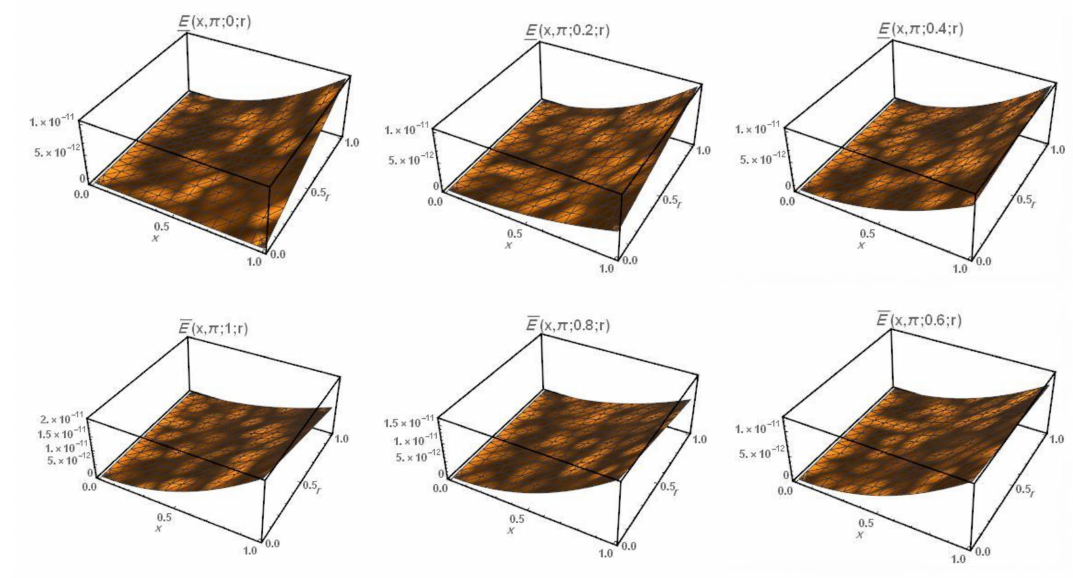
Figure 8. Accuracy of the tenth-order double parametric fuzzy HPM solution at t = π , b = 0,0.2,0.4,0.6,0.8,1 for all x ∈ [ 0,1 ] and r ∈ [ 0,1 ]